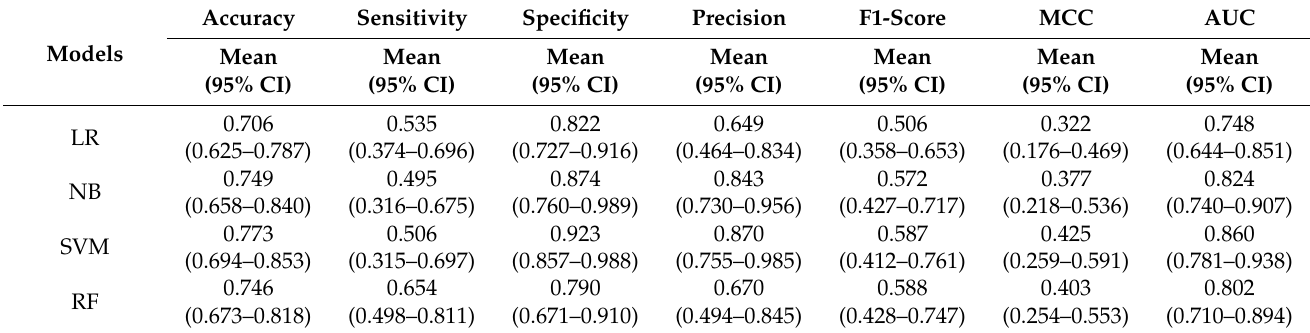
Table 3. Predictive performance of non-invasive intracranial pressure prediction models.